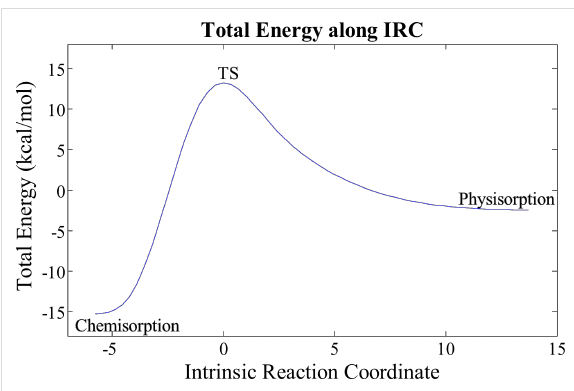
Figure 6: Intrinsic reaction pathway for CO 2 chemisorption on 1 e − -charged BC 59 from the physisorbed configuration. The total energy = 0 point corresponds to the total energy of E CO2 + E BC59 − 1